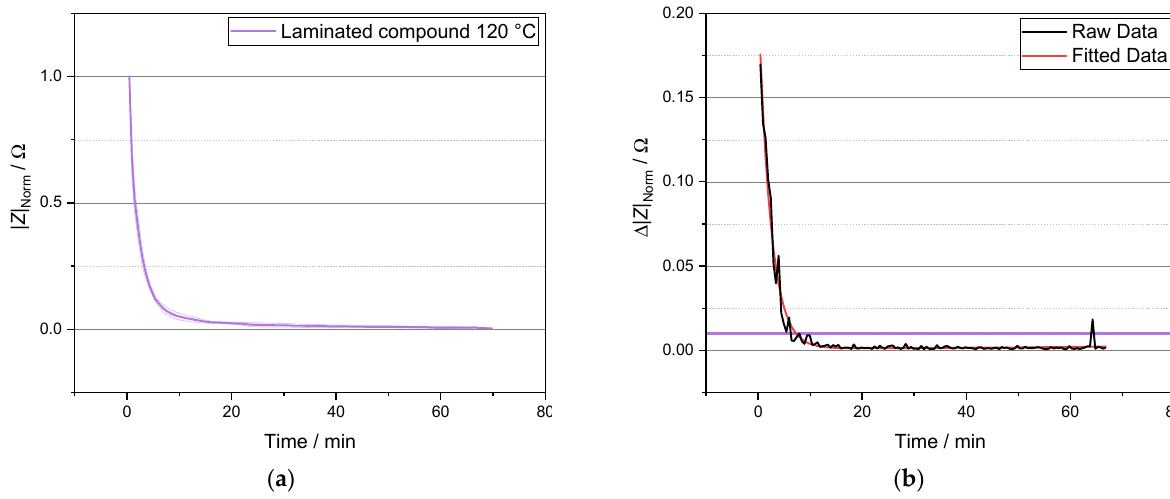
Processes 2021 , 9 , x FOR PEER REVIEW